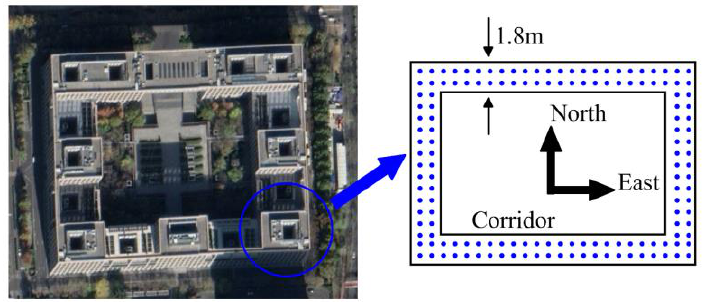
Figure 7. Experiment sites and its simplified diagram.